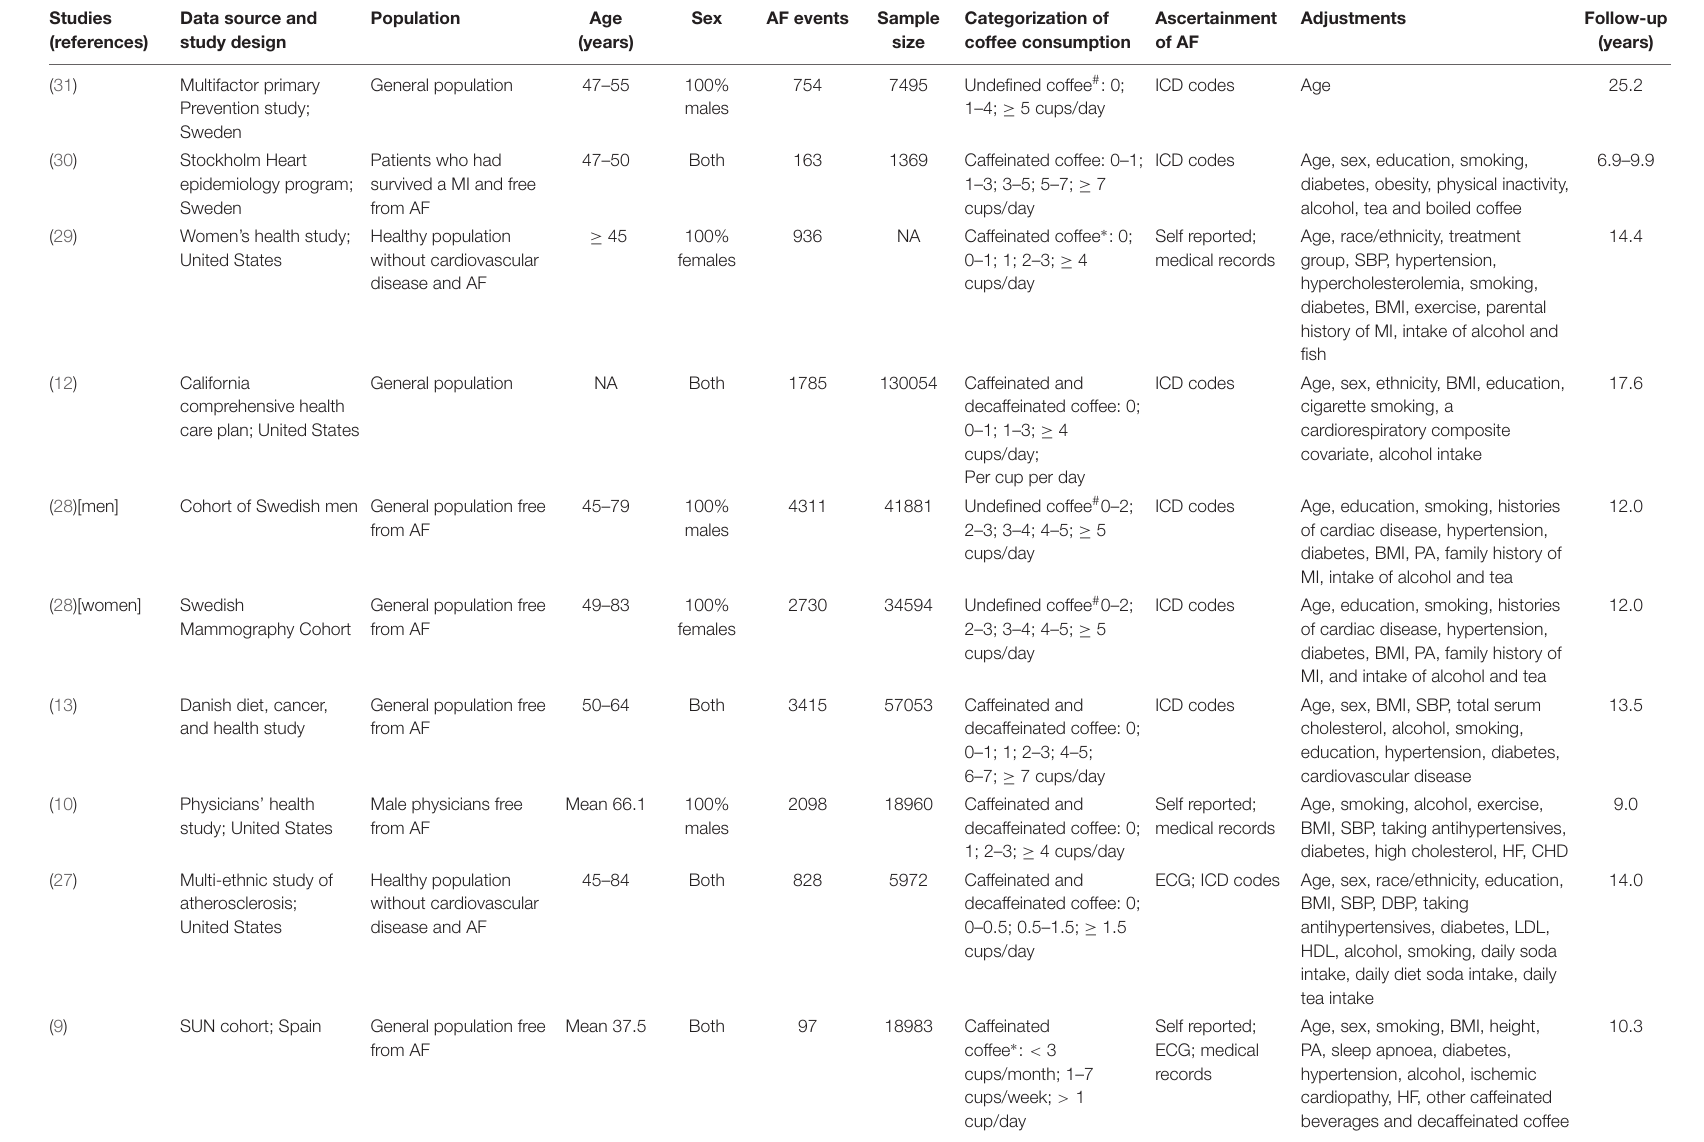
TABLE 1 | Baseline characteristics of the included studies of this